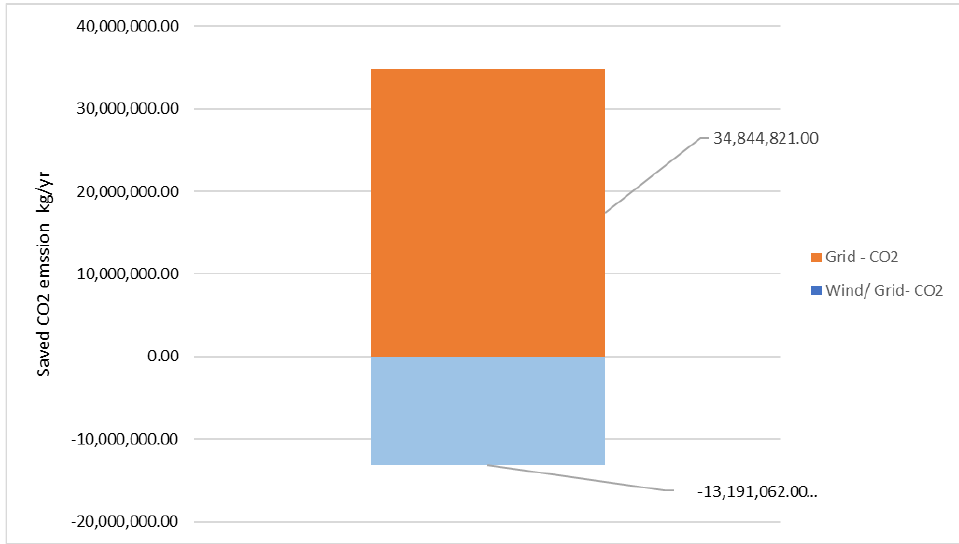
Figure 10. Expected amount of saved CO 2 emissions .